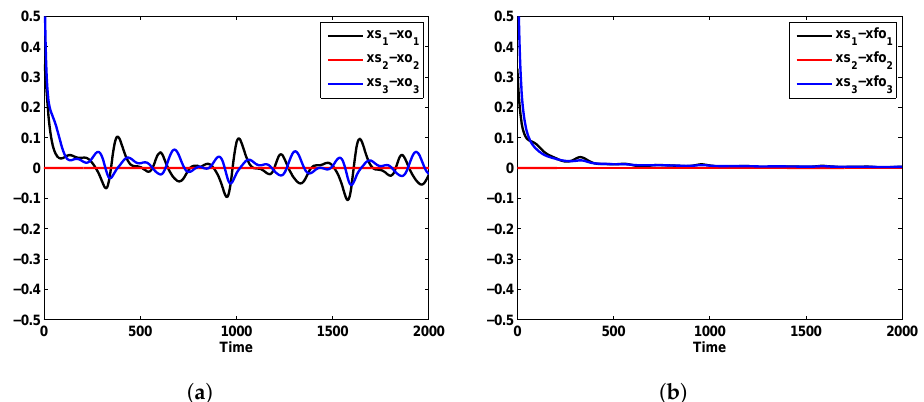
Figure 8. Output estimation error in faulty case. ( a ) State estimation error between the FOTS system and FUIO in a faulty case. ( b ) State estimation error between the FOTS system and FOUIO in a faulty